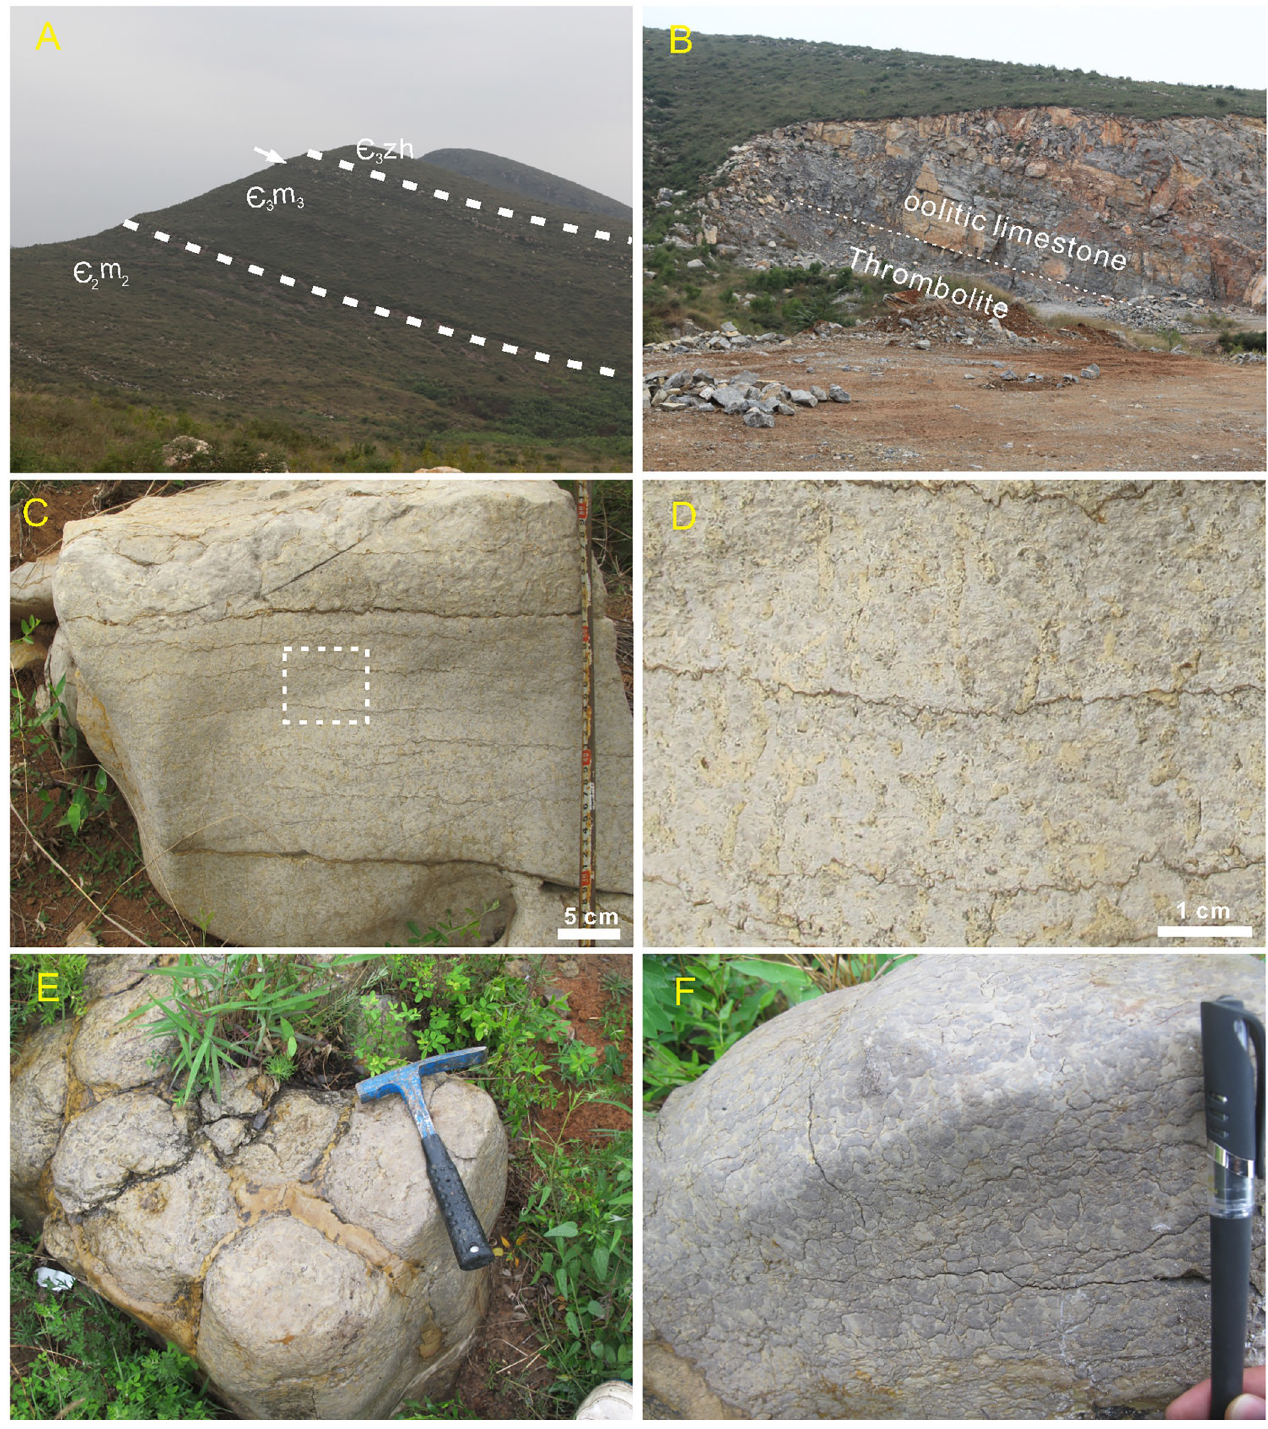
Fig 2. Photograph of section and thrombolites. (A) Overview of the Cambrian succession in the study area. The white arrow denotes the thrombolite horizon (B) Sharp contact between microbialite and overlying oolitic limestone (dashed line). (C) Stratiform thrombolite comprising yellow and black clots. (D) Enlargement of the rectangular area in (C) to show bifurcating clots perpendicular to bedding surfaces and truncated by the upper argillaceous stylolite. (E) Thrombolites comprise domed mounds and argillaceous interstitial matter. Hammer length = 33 cm. (F) Domed mounds showing the grey infillings and black clots that stack perpendicularly to bedding. Gel pen length = 14